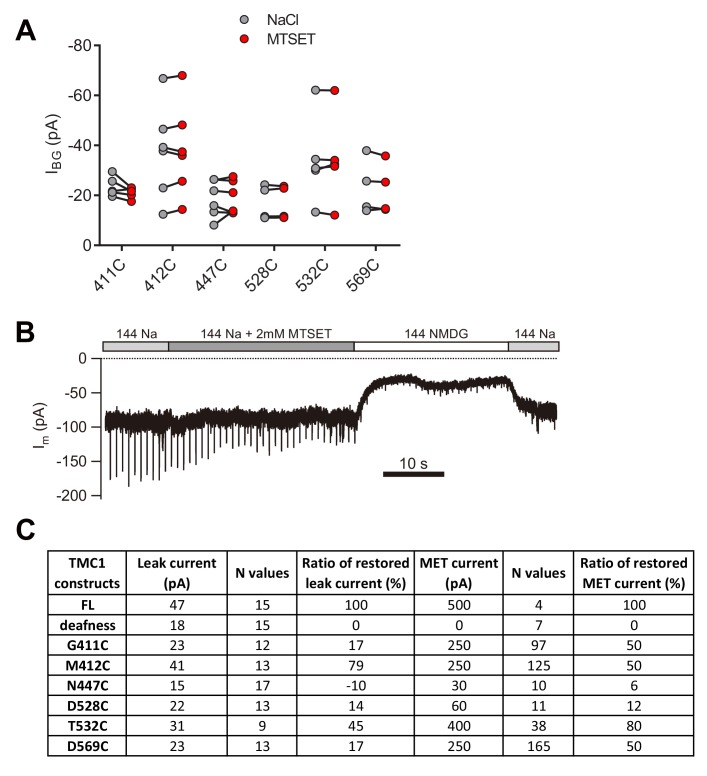
Cysteine substitution in TMC1 affects the MET current and the leak current.(A) Plots of amplitude of the background current recorded from Tmc1-knockout OHCs expressing engineered TMCs as indicated, before and after MTSET treatment. (B) Representative trace of Im recording in a P1 + 3 DIV Tmc1;Tmc2 double-knockout OHC expressing TMC1-M412C. A 10 Hz train of 800 nm step deflection was applied to the hair bundle by a glass probe. (C) Summary of absolute values and normalized ratios of ILeak and IMET. The ILeak values were measured from data in Figure 4. The restored MET values of all TMC1 constructs were measured from Pan et al. (2018), excepting that of dn, which was collected in vestibular hair cells from Kawashima et al. (2011).10.7554/eLife.47441.014Figure 4—figure supplement 1—source data 1.Cysteine substitution in TMC1 affects the MET current and the leak current.